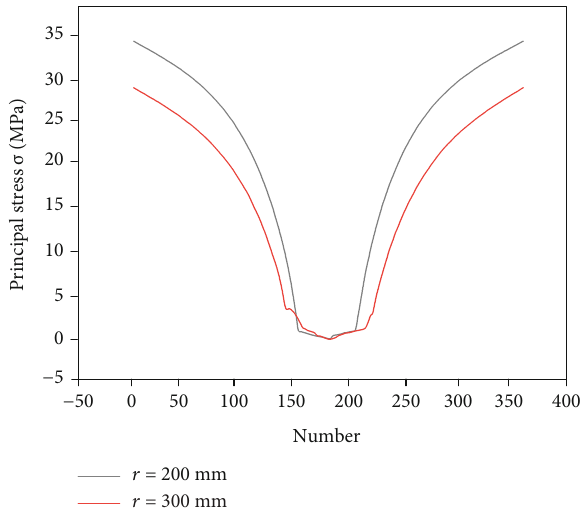
Figure 10: Principal stress distribution of 200-mm and 300-mm